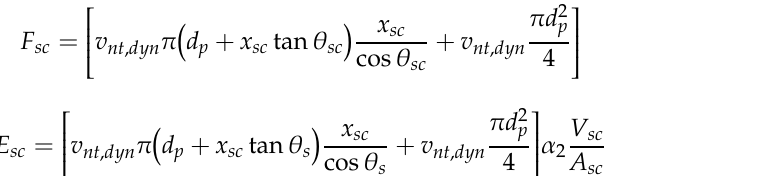
Figure 2. Stress flow on interface between scabbed concrete and slab.